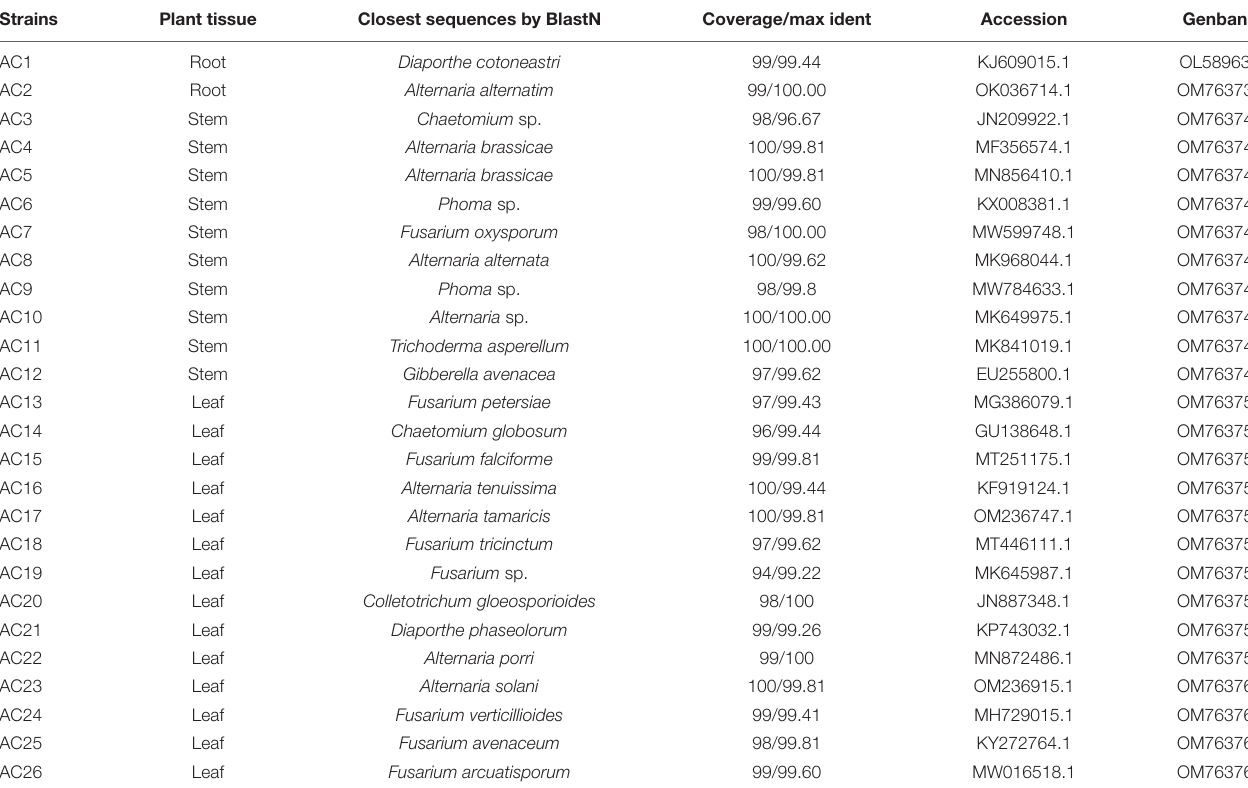
TABLE 1 | The separation tissues and homologous strains of endophytic fungi from A. argyi. Strains Plant tissue Closest sequences by